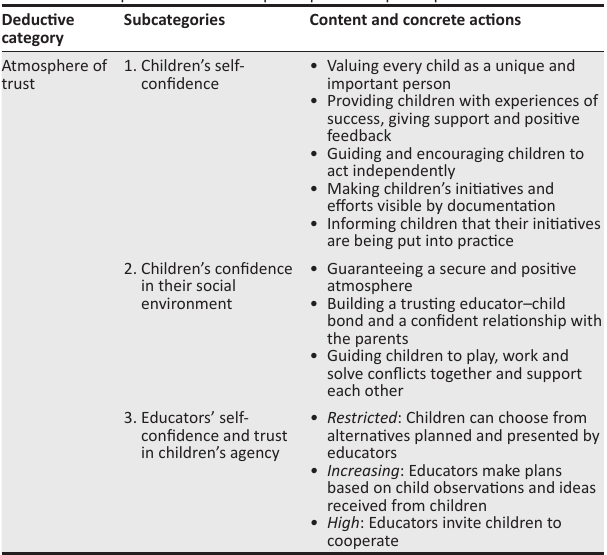
TABLE 1: Atmosphere of trust as a prerequisite for